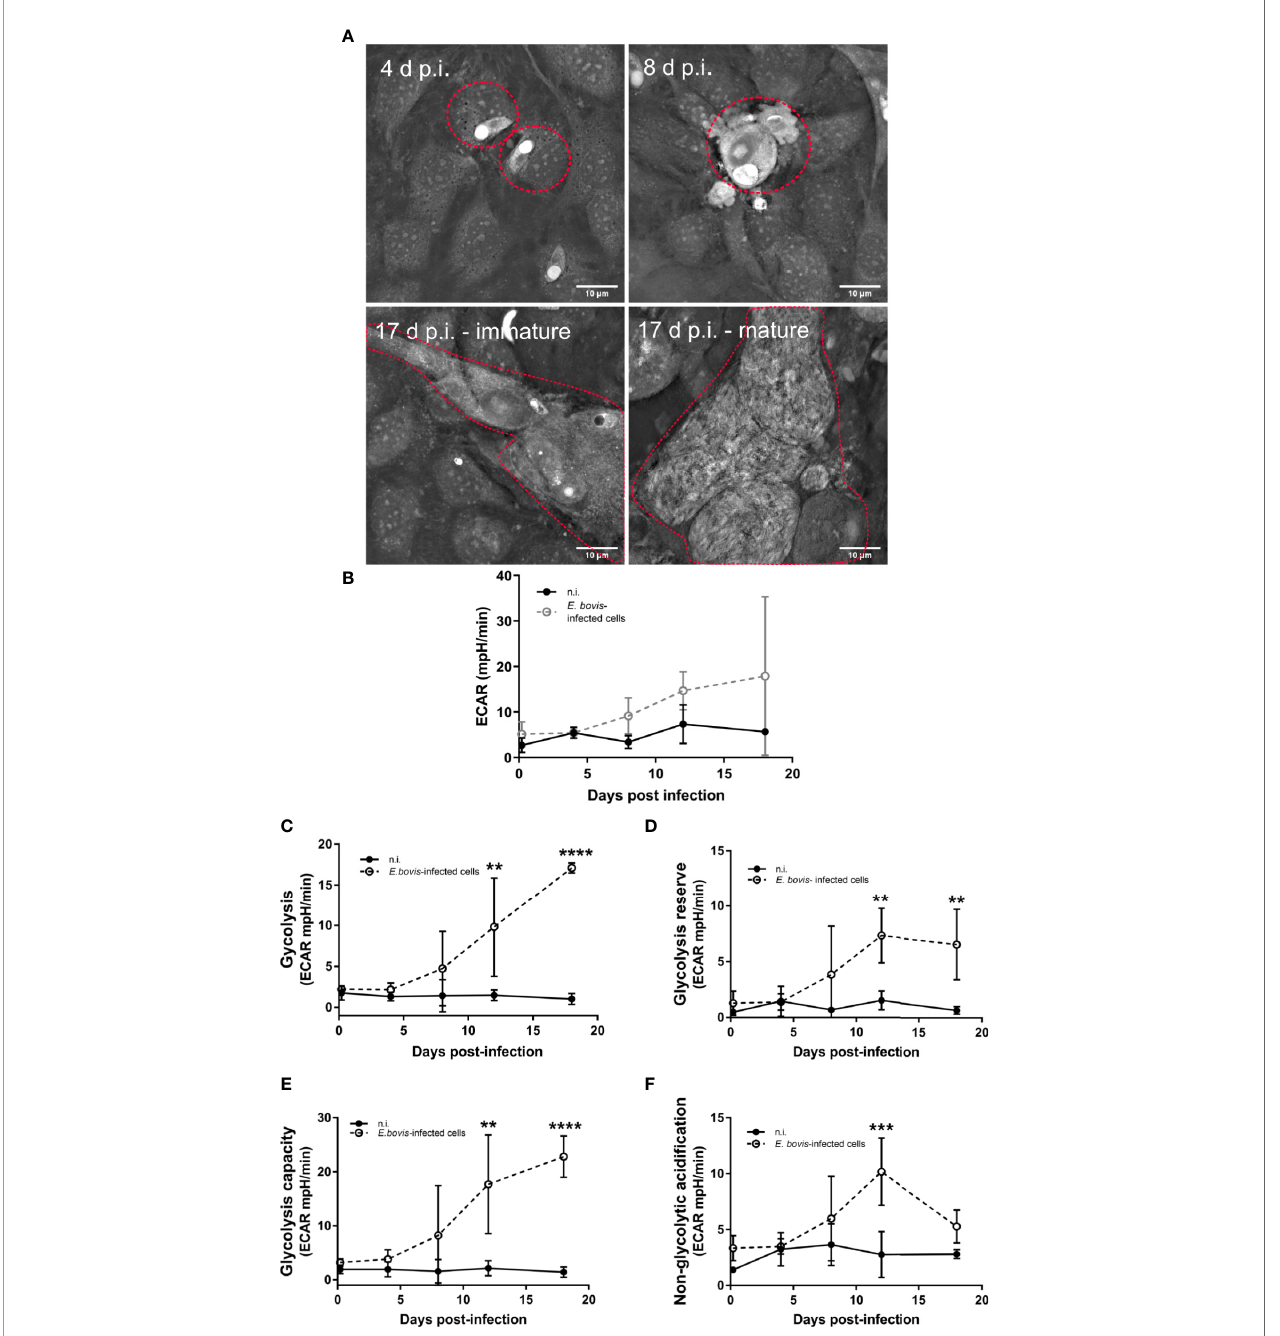
FIGURE 1 | Analysis of the glycolytic metabolism during the E. bovis in vitro development in endothelial cells. (A) Con fl uent primary endothelial cells (n = 3) were infected with freshly isolated E. bovis sporozoites. From 4 days p. i. onward, the same cell layer was monitored microscopically to evaluate parasite development. 3D-holotomographic microscopy used refractive indexes (RI) of cell components to reconstruct and visualize the total cell and meront structures over time. Premature and mature meronts I structure were observed from 17 days p. i. (B – E) BUVEC were infected with E. bovis sporozoites and tested for glycolytic responses by a glycolysis stress test (Agilent). After sequential supplementation of 10 mM glucose, 1 m M oligomycin, and 50 mM 2-DG, several glycolytic parameters were measured, in E. bovis – infected ( ◌ ) and non-infected cells ( (cid:129) ) at the indicated days p. i. ECAR (B) , glycolysis (C) , glycolysis reserve (D) , glycolysis capacity (E) , and non-glycolytic acidi fi cation (F) were determined at 4 h p. i. and 4, 8, 12, and 18 d p. i. Statistical analysis was performed by using two-way ANOVA with repeated measurements de fi ning the time as the matching variable (signi fi cance de fi ned as p ≤ 0.05). Values are expressed as means ± SD of three biological replicates. ** p ≤ 0.01, *** p ≤ 0.001, **** p ≤